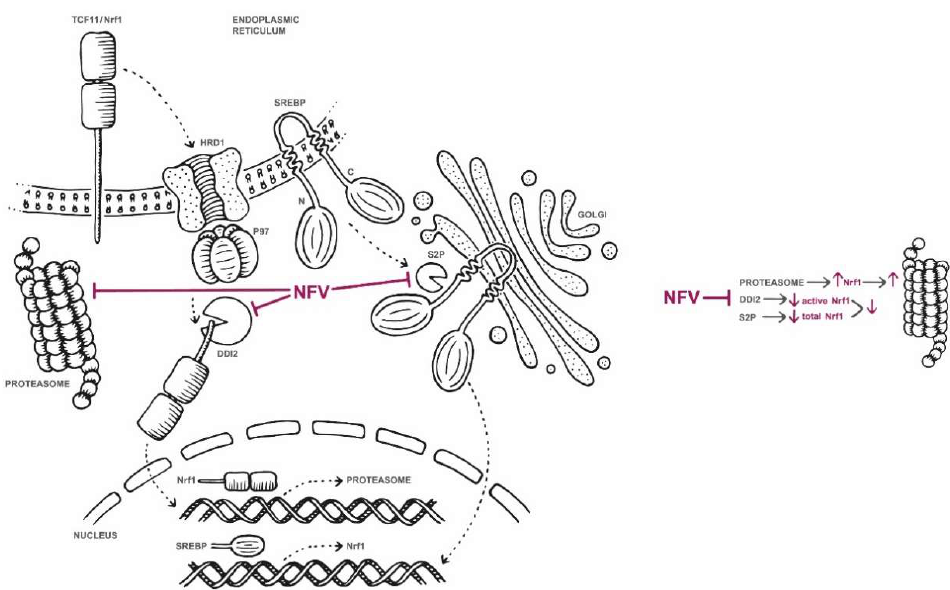
Figure 7. Suggested model of nelfinavir’s modes of action related to proteasome synthesis and activity. At concentrations ≥ 40 μM, nelfinavir partially inhibits β1/β5 and β2 activity of the proteasome [24], thus activating TCF11/Nrf1-dependent proteasome re-synthesis (the bounce-back